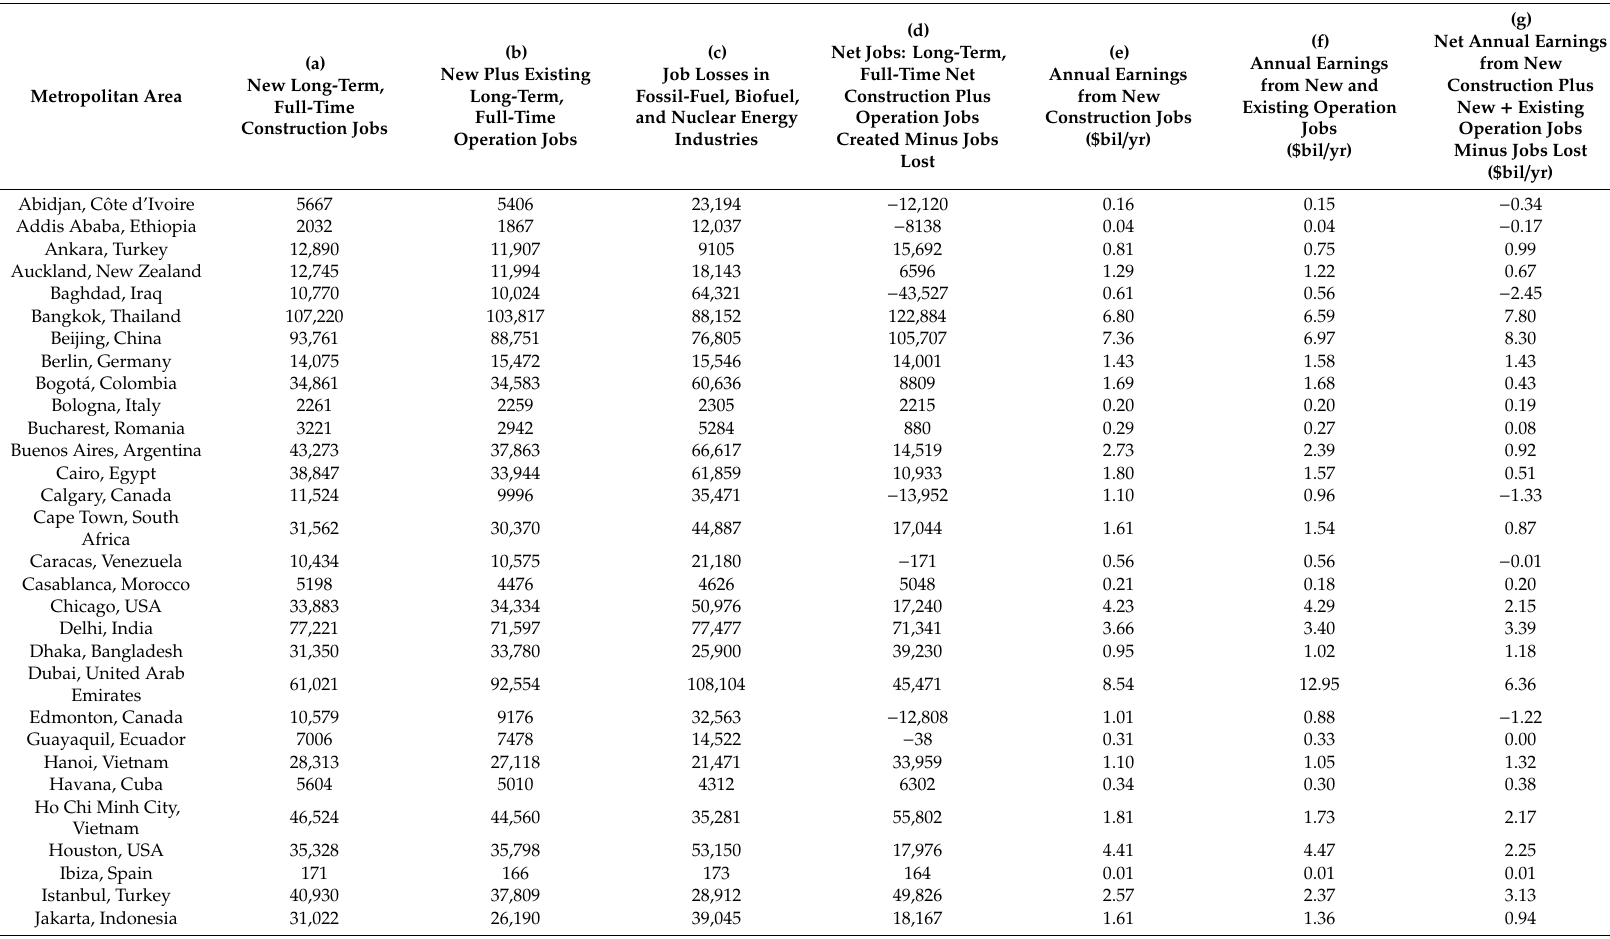
Table 10. Estimated numbers of 2050 new long-term, full-time ( a ) construction and ( b ) operation jobs produced due to converting to 100% WWS. ( c ) Job losses due to the transition. ( d ) Long-term, full-time construction plus operation jobs produced minus jobs lost. Annual earnings corresponding to new ( e ) construction and ( f ) operation jobs produced. ( g ) Net earnings from new construction plus operation jobs produced minus jobs lost due to converting to 100% WWS. Costs are in 2013